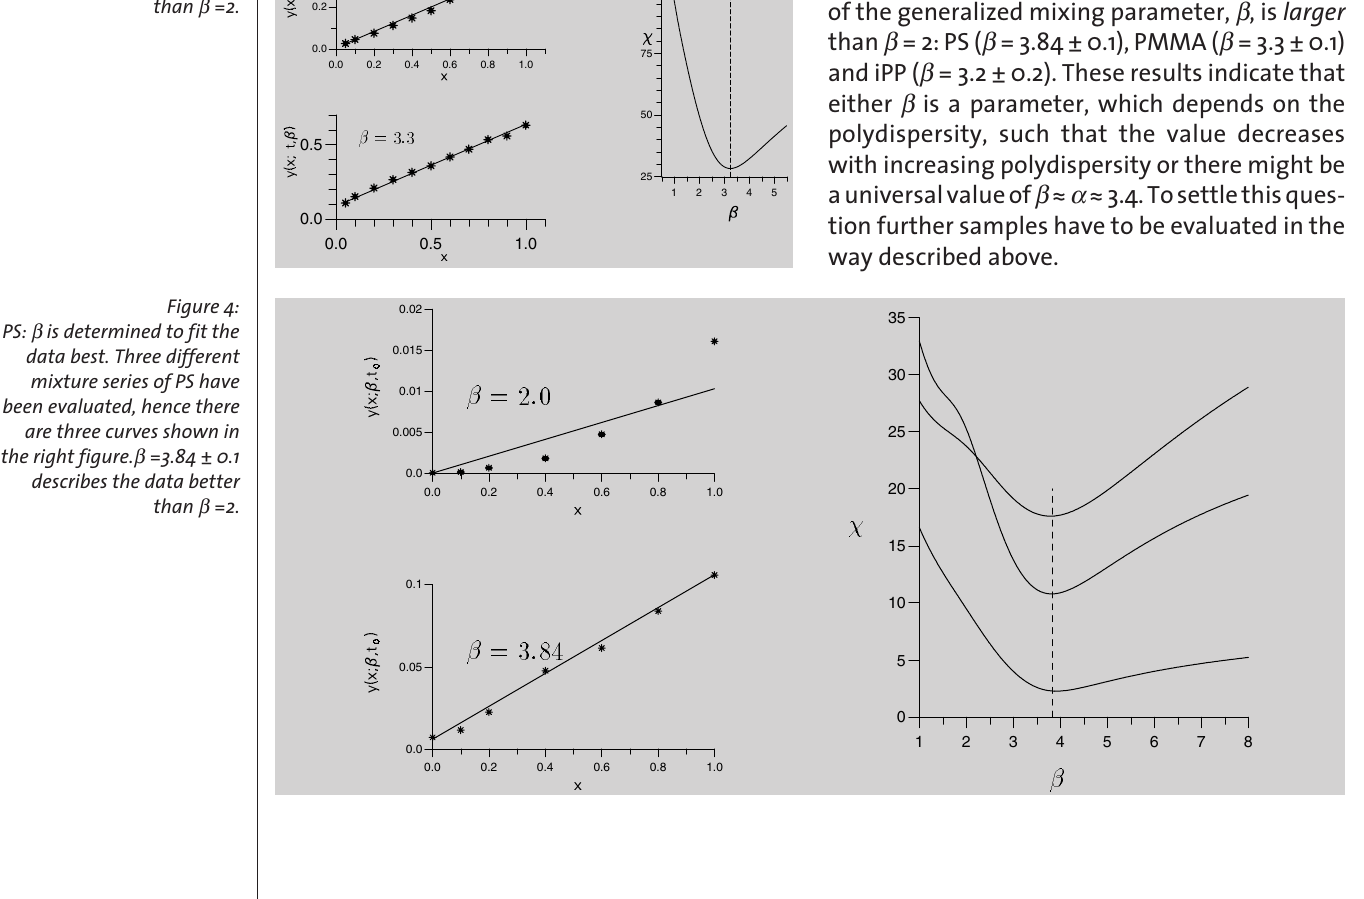
Figure 2: iPP: β is determined to fit the data best. β =3.2 ± 0.2 describes the data better than β =2.